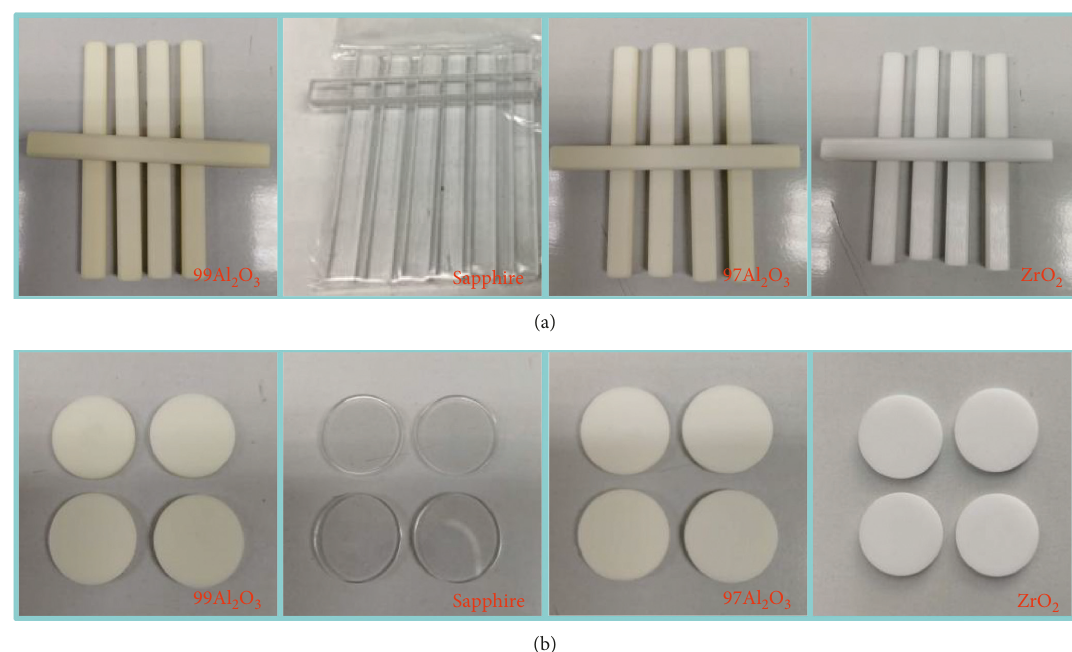
Figure 3: Test specimen: (a) size of 3.5 × 5 × 50mm 3 and (b) size of φ 12.5 × 1.5 mm 3